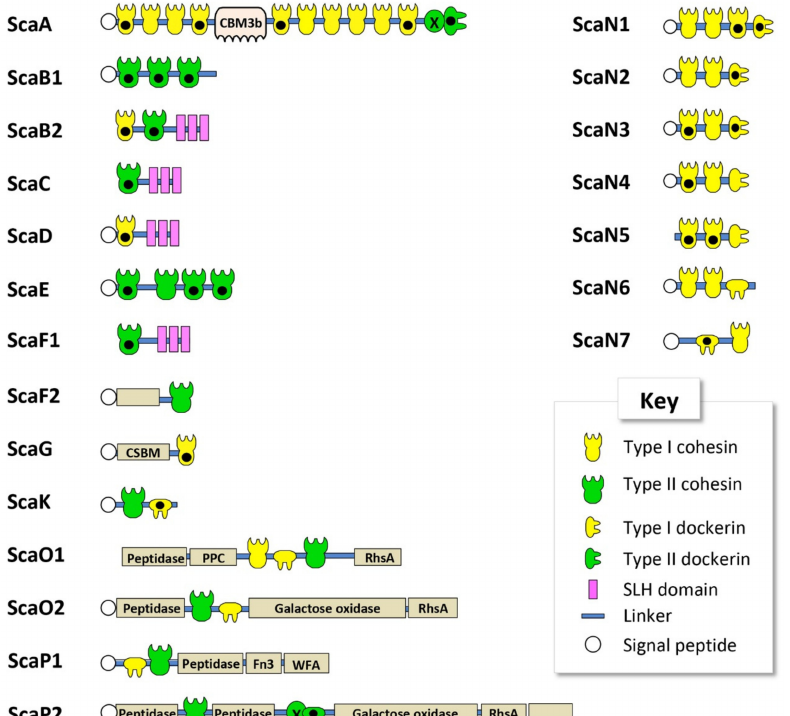
Figure 1. Schematic representation of the cohesin-containing proteins, identified bioinformatically in the Clostridium alkalicellulosi draft genome. Black dots indicate cohesin and dockerin modules of the designated sca ff oldins that were expressed and examined for specific interactions in the current study.